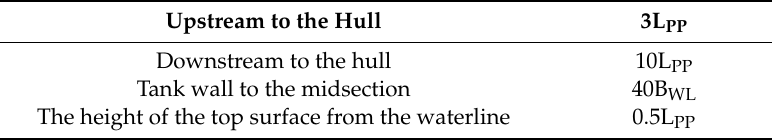
Table 3. The CFD computational domain size of the full-scale (half